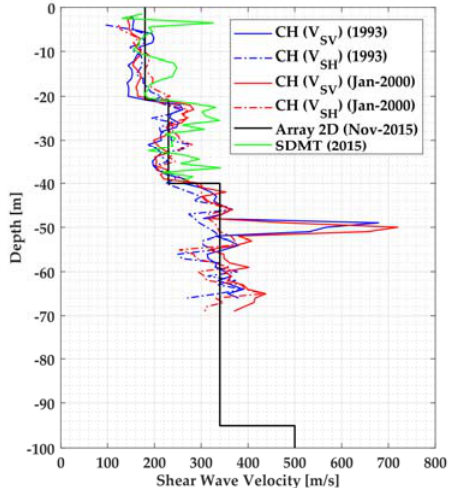
Figure 5. Profile of the shear wave velocity.